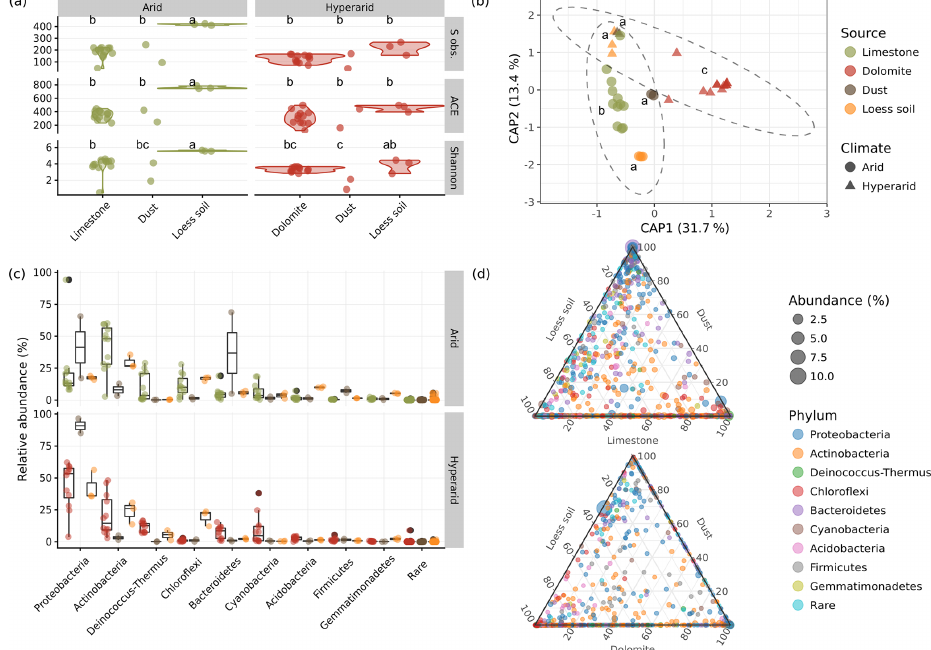
Figure 4. Microbial community features of the BRCs, the surrounding soils, and settled dust at the two study sites. (a) Comparison of the richness in the form of the observed number of OTUs (S obs.) and the predicted number of OTUs (the ACE index), in addition to a comparison of α -diversity (Shannon diversity index – H) between the different sample types. Identical lower-case letters indicate no statistical difference between groups in a Tukey HSD test. (b) Clustering of sample types using a PCoA ordination based on the Horn–Morisita distance matrix. Identical lower-case letters indicate no statistical difference between groups in a pairwise PERMANOVA test. Ellipses denote 95% confidence intervals around the arid and hyperarid samples assuming multivariate normal distribution. (c) Composition of bacterial phyla in the different sample types (see Table S5 for results of statistical tests in the relative abundance of different phyla between sample types). (d) Relative contribution of each bacterial OTU to the community composition of each sample type: top – arid site, bottom – hyperarid site (see Fig. 5 for statistical detection of preferentially abundant OTUs between each sample-type